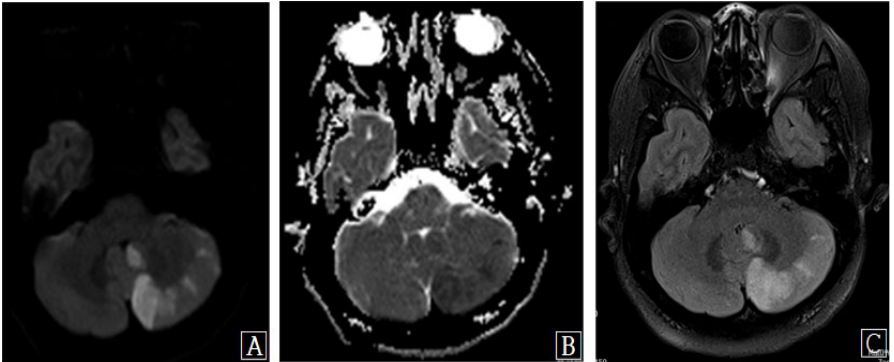
Figure 2. Brain magnetic resonance (MR) images show multiple patchy foci of diffusion restriction, consistent with acute left posterior inferior cerebellar artery territory infarction. ( A ) Diffusion-weighted MR image. ( B ) Apparent diffusion coefficient MR image. ( C ) Axial T2 flair MR image.